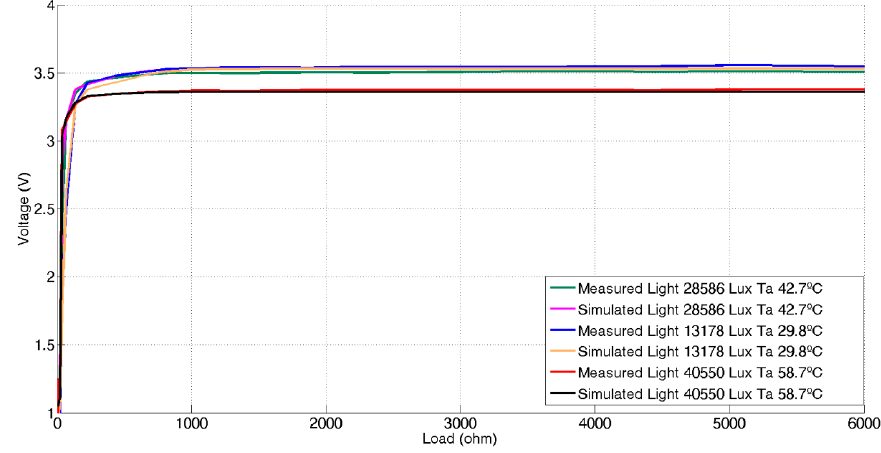
Figure 6. Real and simulated voltage-to-load curves at three different light and temperature conditions.